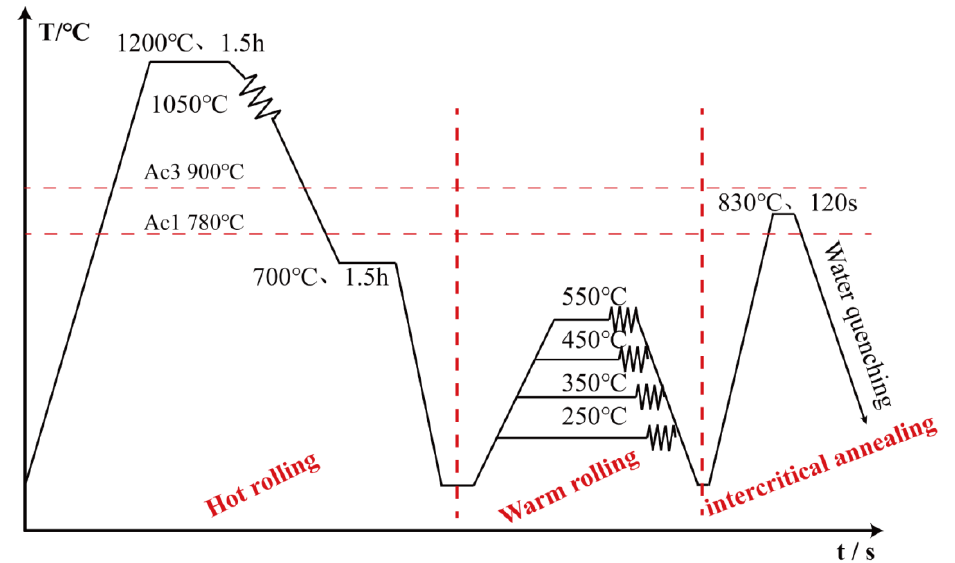
Figure 1. Schematic illustration of the manufacturing process.